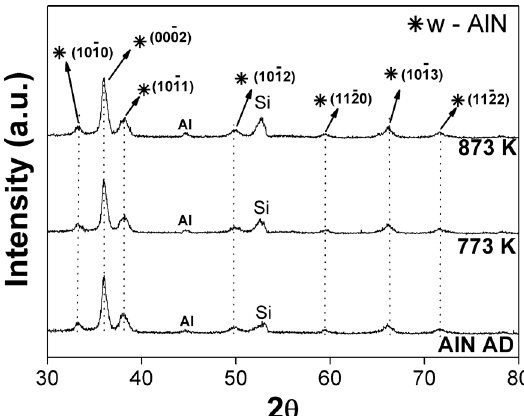
Figure 7. GAXRD patterns for pure AlN as deposited and after oxidation tests at 773 and 873